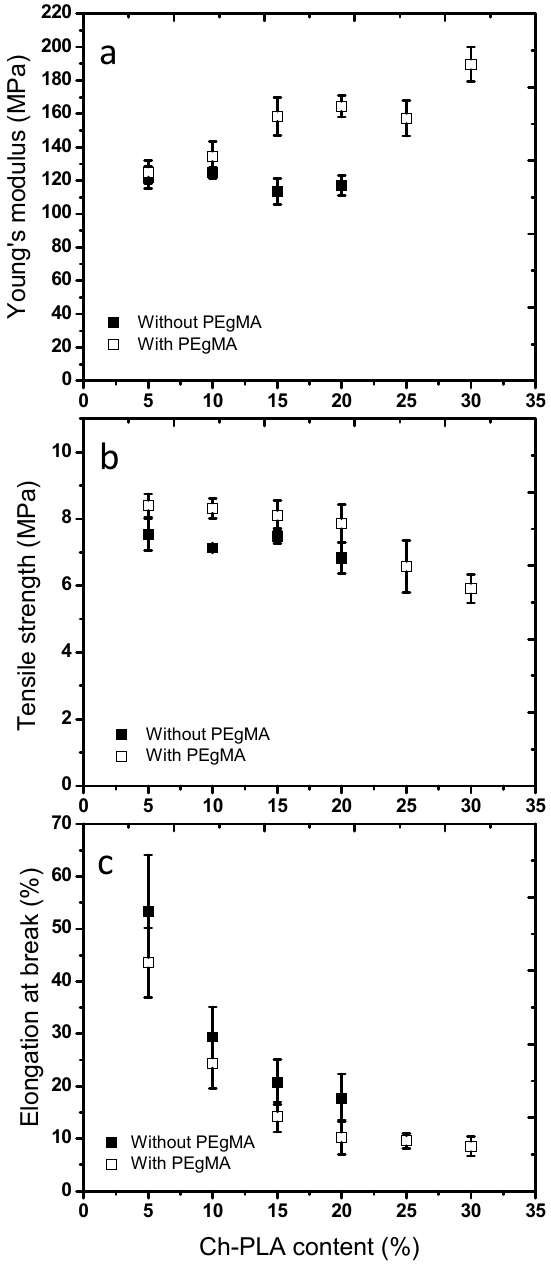
Figure 6. ( a )Young’s modulus, ( b ) tensile strength and ( c ) elongation at break, in films of PE/Ch-PLA as a function to Ch-PLA